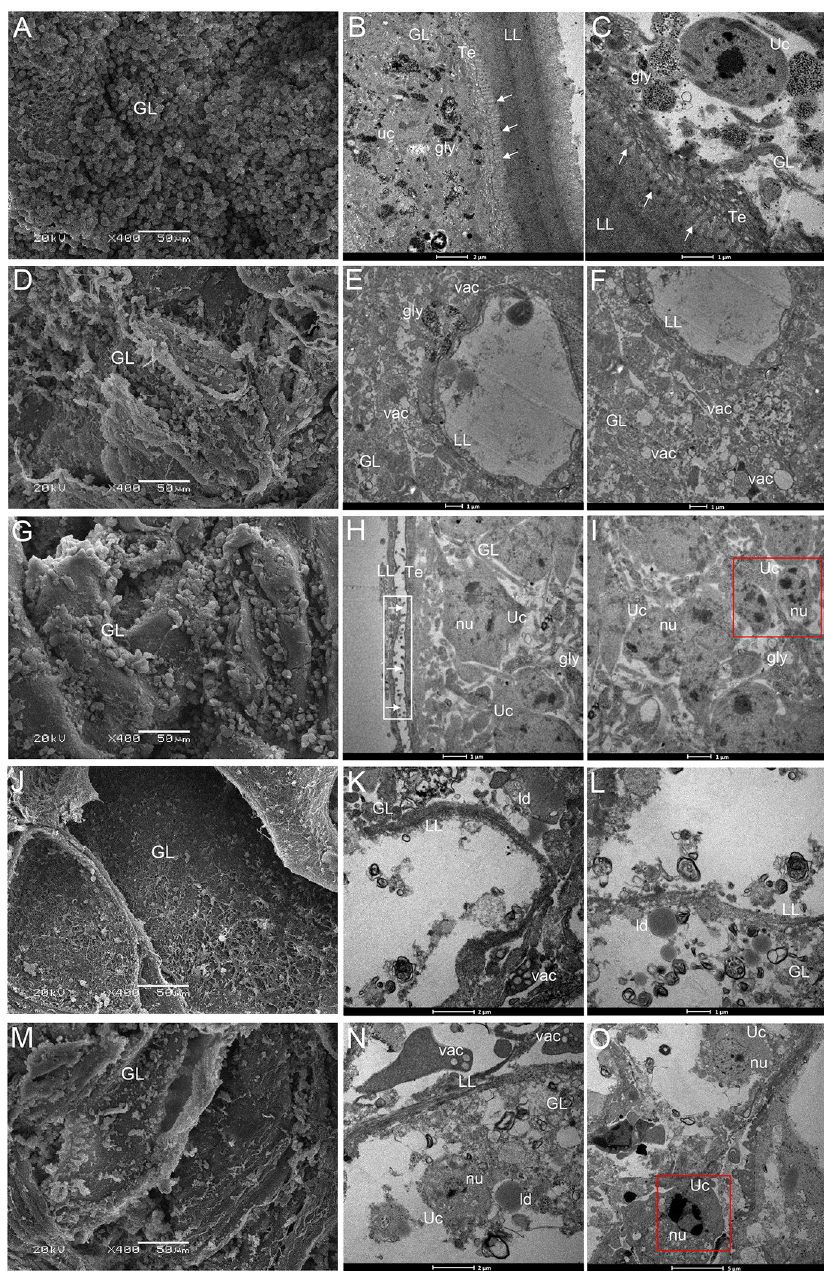
Fig 5. Ultrastructural alterations of metacestodes in different treatment groups. (A) Scanning electron microscopy (SEM) and transmission electron microscopy (TEM) (B and C) show metacestodes from untreated mice. The metacestode has a characteristic structure with an intact germinal layer surrounded by an acellular laminated layer. The arrows indicate microtriches originating from the tegument and protruding into the laminated layer. Note the large number and the length of microtriches. (D) SEM and TEM (E and F) show metacestodes from ABZ-treated mice. Note the complete absence of microtriches at the tegument and regression of the germinal layers. (G) SEM and TEM (H and I) show metacestodes from 2-DG–treated mice. Note the profound shortening and reduced number of the microtriches (marked by a white box and arrows) and a less dense appearance of the germinal layer tissue. Moreover, the characteristic features of apoptosis are visible in undifferentiated cells (marked by a red box). (J), (K), (L) and (M), (N), and (O) show metacestodes from mice treated with ABZ + 2-DG and ABZ half-dose + 2-DG. The metacestodes exhibited complete breakdown of the structural integrity of the vesicles; there was a complete loss of microtriches, and only residual laminated layers lacking any cellular parasites components were found in many areas. LL, laminated layer; GL, germinal layer; Teg, tegument; Uc, undifferentiated cells; gly, glycogen storage cells; vac, vacuolization of the tissue; nu, cell nucleus; ld, lipid drops.